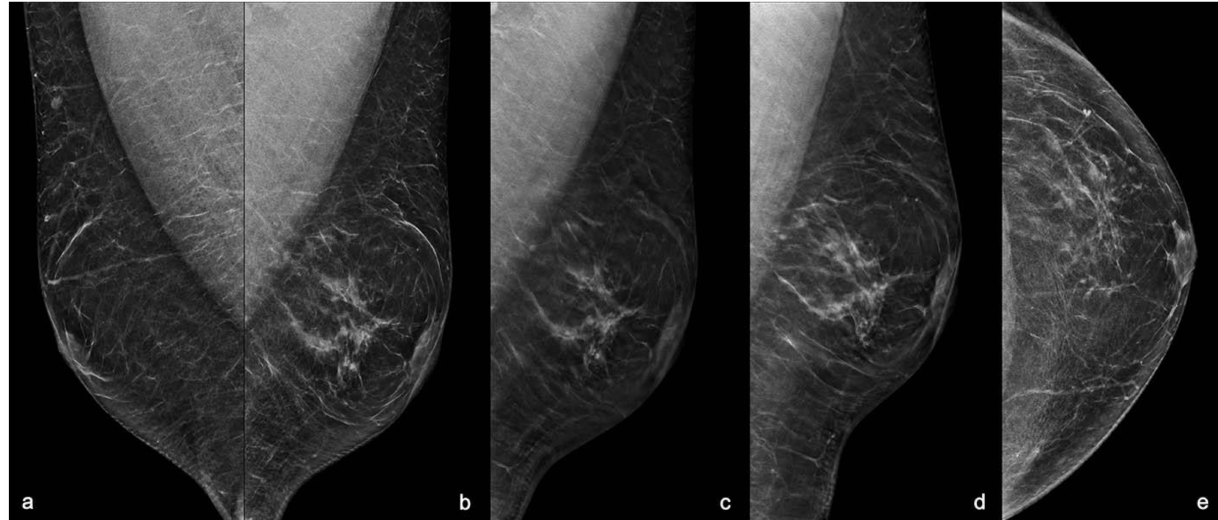
Figure 1. Mammography with s2D and DBT projections. ( a ) Right MLO s2D showing normal appearance of male breast with false gynaecomastia. ( b ) Left MLO s2D; ( c ) Left MLO DBT; ( d ) Left LM s2D; ( e ) Left CC s2D. 2D mammograms showed an area of asymmetric density at the union of outer quadrants of the left breast with regular breast buttons in absence of gynaecomastia. DBT showing the area of architectural distortion at the union of outer quadrants of the left breast with rare punctate microcalcifications and small peripheral pseudo-nodular opacities referred to focal ductal ectasia, sparing the nipple-areolar complex. MLO: medio-lateral-oblique projection; LM: latero-medial projection; CC: cranio-caudal projection; s2D: 2D synthetic reconstruction; DBT: digital breast